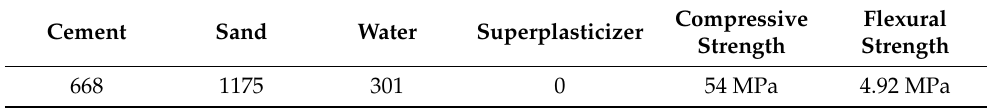
Table 4. Mix design of mortar in the test for parameter analysis of the linear cohesion model (kg/m 3 ).